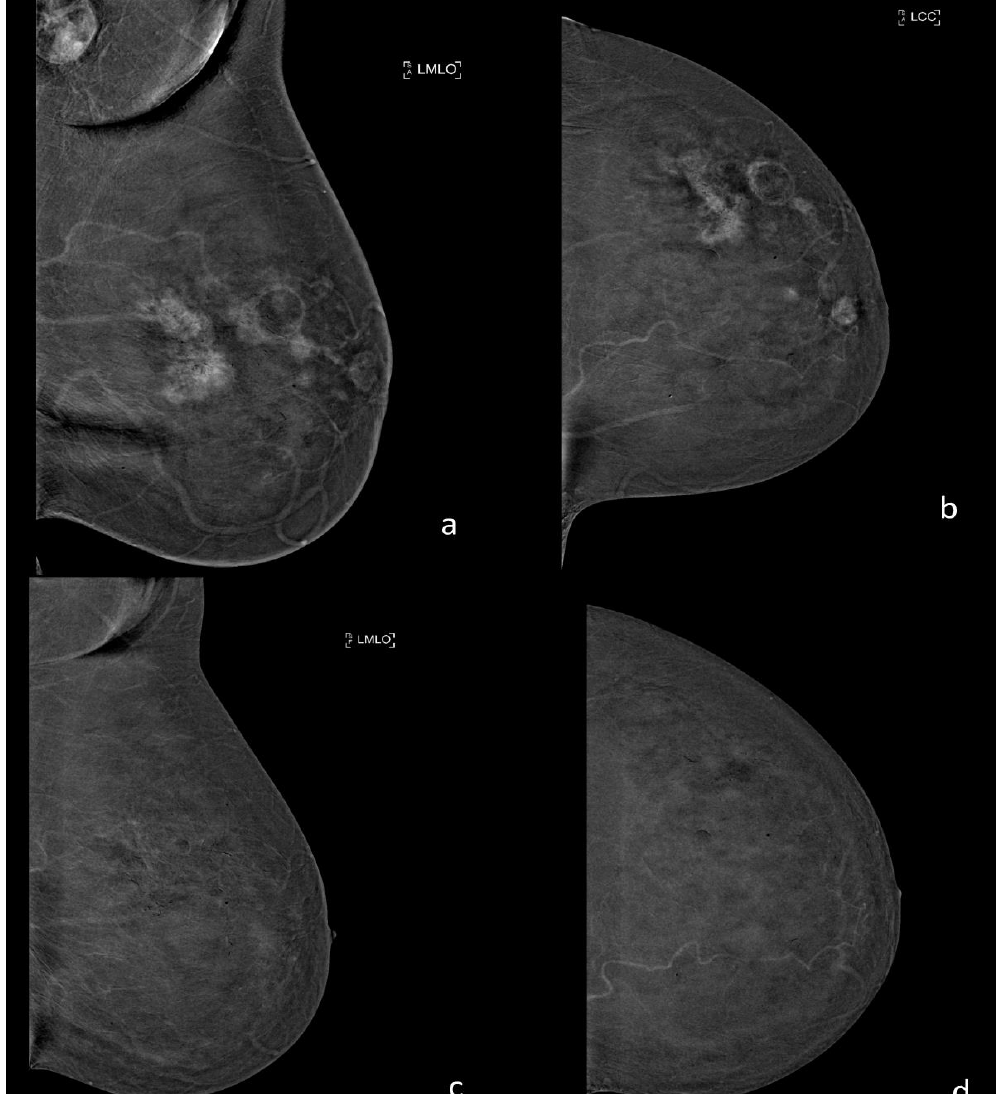
Figure 4. Examination with CEM before and after neoadjuvant chemotherapy of a 55-year0old patient with a multicentric invasive ductal and lobular carcinoma of the left breast. ( a , b ) CEM recombined images before neoadjuvant chemotherapy show multiple masses associated with an area of non-mass enhancement referable to the index lesion and a pathological lymphadenopathy in the ipsilateral axillary cavity. ( c , d ) CEM recombined images after neoadjuvant chemotherapy show the complete absence of pathological enhancement in the left breast, and also the regression of the axillary lymphadenopathy. The post-surgery histology confirmed the complete regression of the disease.